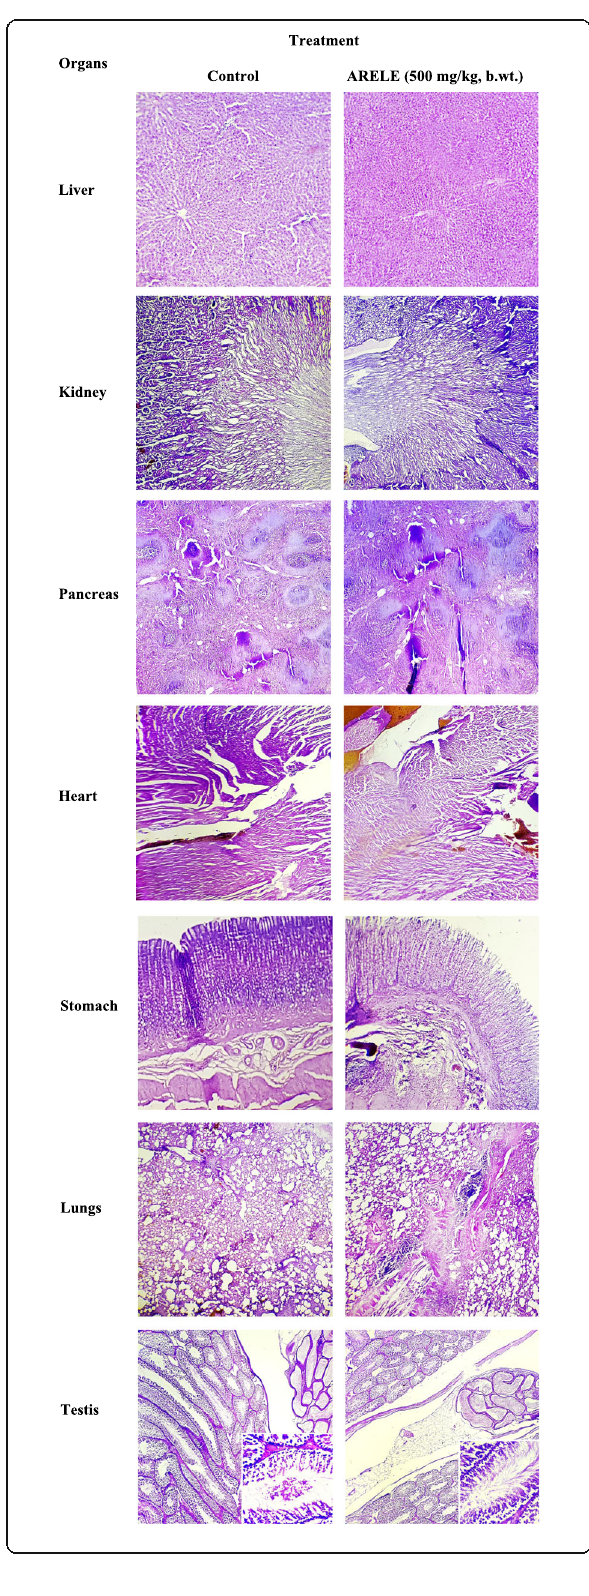
Fig. 3 Histopathological study of vital organs from male rats. Photomicrographs of histological findings of different organs from male rats treated with normal control vehicle and ARELE at high dose (500 mg/kg, b.wt.) for a period of 30 days (H&E staining, 40 × magnification, magnified parts in testis = 100 ×